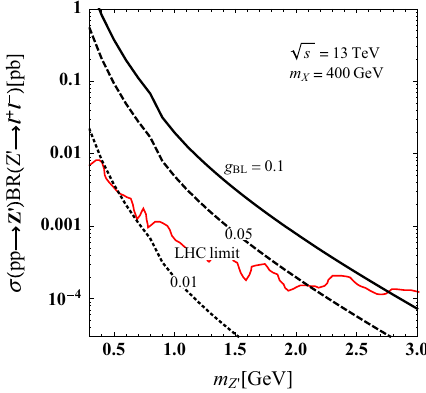
Fig. 2 σ( pp → Z (cid:2) ) BR ( Z (cid:2) → (cid:5) + (cid:5) − ) , (cid:5) = e and μ , as a function of √ m Z (cid:2) at s = 13 TeV with g BL = 0 . 1, 0 . 05 and 0 . 01 as indicated in the plot. The red curve shows the upper limit from the ATLAS experi- ment [14]